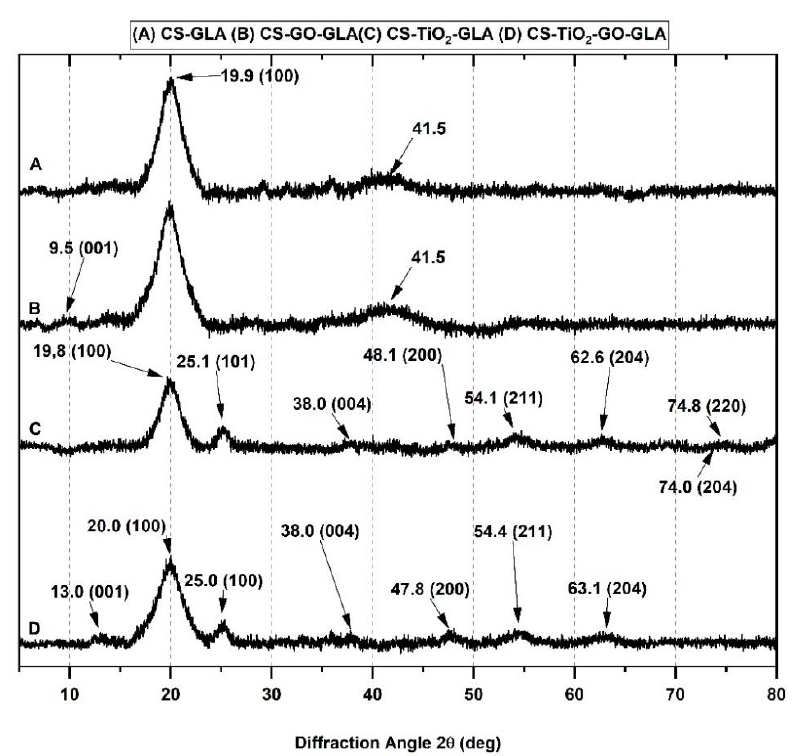
Figure 4. X-ray diffraction (DRX) of the different nanocomposite beads: ( A ) CS-GLA, ( B ) CS-GO-GLA, Figure 4. X-ray di ff raction (DRX) of the di ff erent nanocomposite beads: ( A ) CS-GLA, ( B ) CS-GO-GLA, ( C ) CS-TiO 2 -GLA, and ( D ) CS-TiO 2 -GO-GLA. ( C ) CS-TiO 2 -GLA, and ( D ) CS-TiO 2 -GO-GLA. Table 1. The crystallinity index (Xc) of the di ff erent formulations calculated from the XRD analysis.